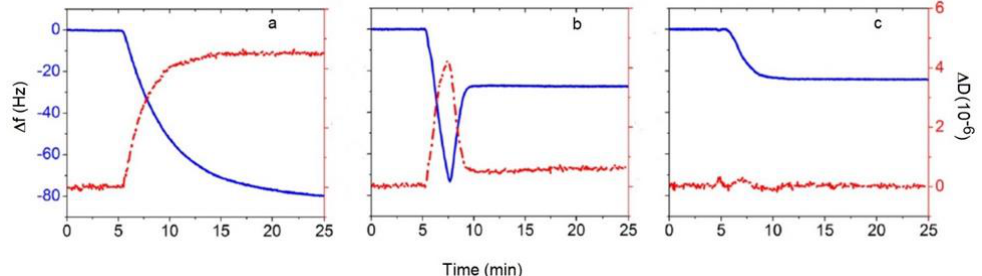
Figure 2. Typical QCM-D responses reflecting the three modes of vesicle – quartz crystal interactions shown in Figure 1. The blue lines are frequency changes with the scale represented on the left axis and the red lines are dissipation changes with the scale represented on the right axis. ( a ) Adsorption of vesicles and formation of a layer of vesicles. ( b ) Adsorption of vesicles followed by their rupture at a critical vesicular coverage and formation of SLB. ( c ) Formation of SLB as soon as the vesicle contacts the substrate. The figures are examples taken from reference [20]. Copyright Jackman et al, Langmuir, 2013.